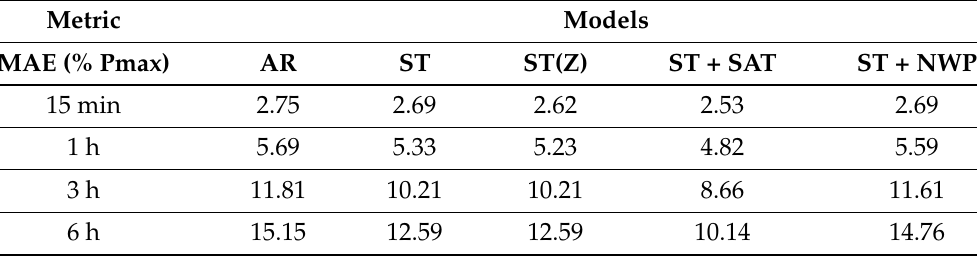
Table 2. MAE of the models for one power plant (P10) of